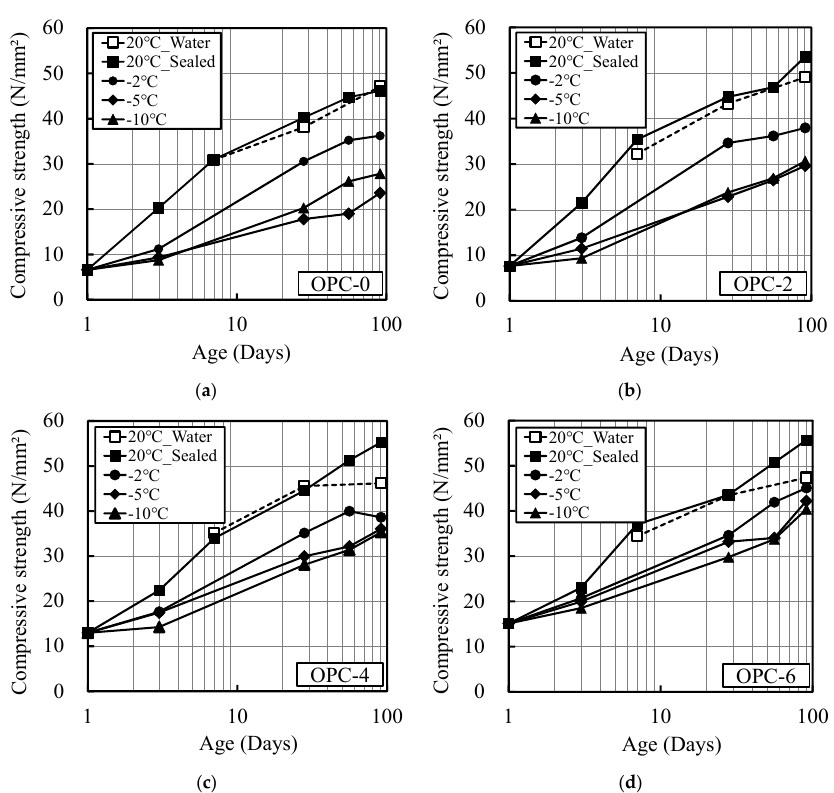
Figure 1. Relationship between compressive strength and age (OPC), ( a ) OPC-0; ( b ) OPC-2; ( c ) OPC-4; ( d )OPC-6.